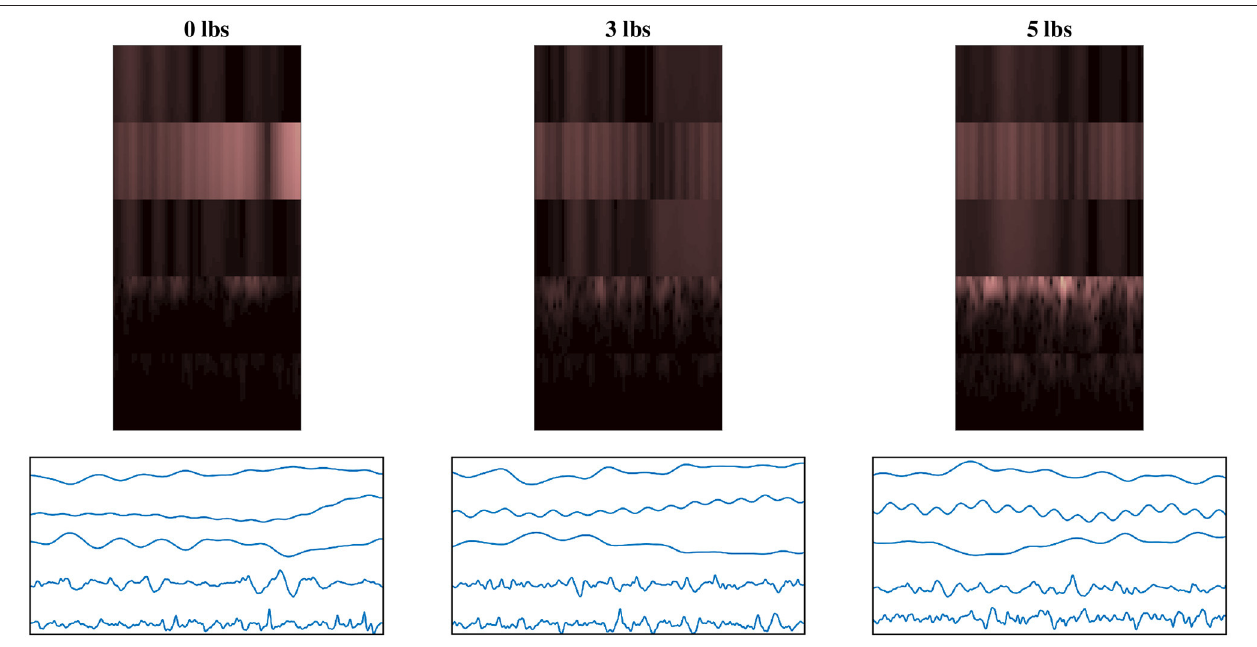
FIGURE 4 | Example normalized spectrogram images and graphical representations of sample normalized signal images for each of the three weight levels, showing the qualitative variations in the images as task weight changes. During different task weights, the distribution of frequency magnitudes across time/channels is different in the spectrogram images and the shape of the time domain signal varies in the signal images. The columns each represent a different task weight level (described by the label above), with the rows being a matched spectrogram and signal image taken from the same time window. The spectrograms shown use the grouped fusion method to arrange the channels. The images shown follow the same labeling convention as the sample images shown in Figures 2 , 3 , excluded here to avoid clutter.